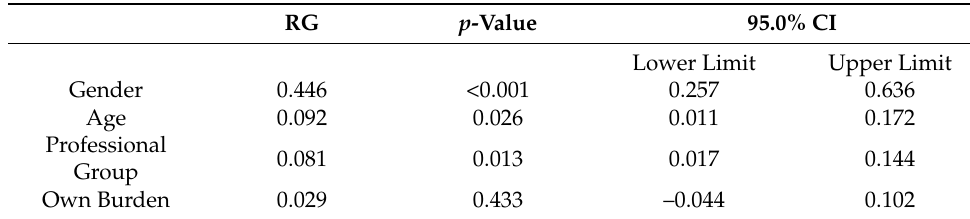
Table 4. Multiple linear